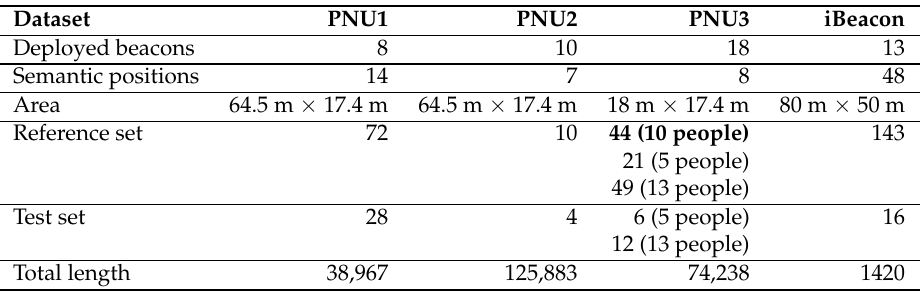
Table 3. Detailed dataset